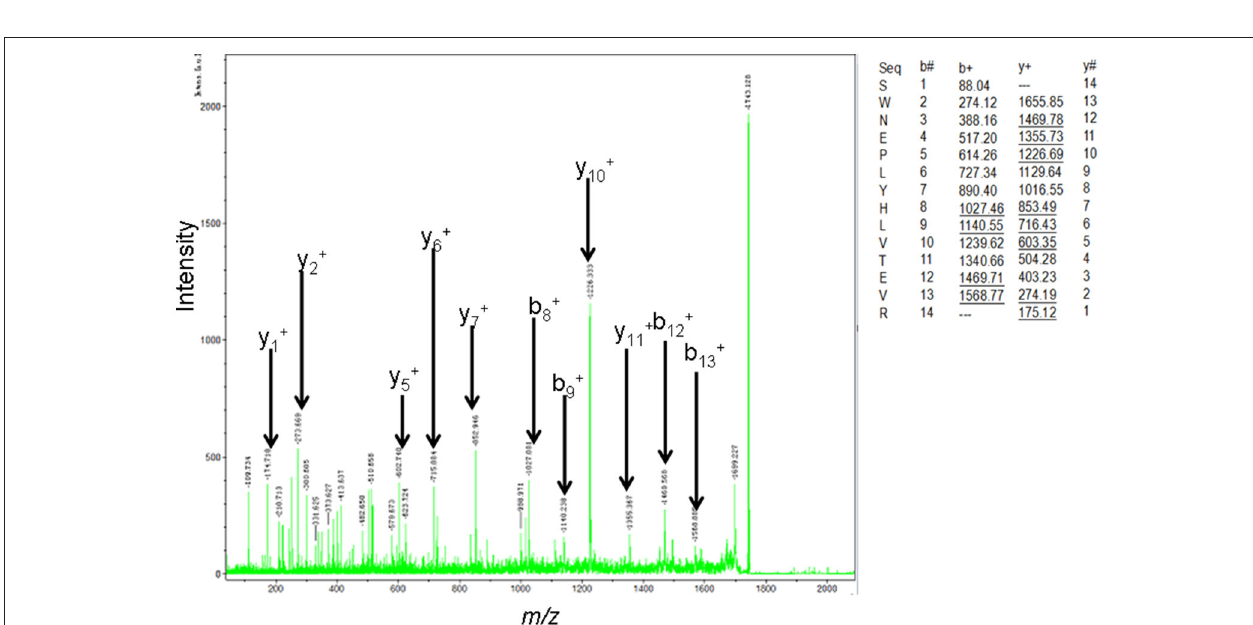
FIGURE 3 | MS/MS spectrum of the tryptic peptide 118 SWNEPLYHLVTEVR 131 that was derived from hPRL in spot v6. The upper right corner is the theoretically calculated b- and y-ions for this analyzed tryptic peptide. The corresponding observed b- and y-ions were labeled in the MS/MS spectrum.